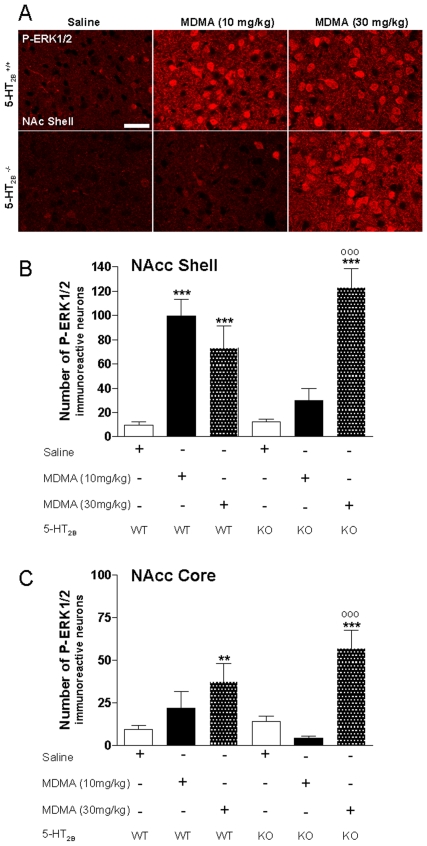
Effect of 5-HT2B receptor on MDMA-induced ERK activation.24 hours after CPP training (Figure 3), the same WT and 5-HT2B
−/− mice were re-exposed to saline, MDMA 10 mg/kg or MDMA 30 mg/kg before being processed for immunohistochemistry. A) Single confocal sections showing p-ERK1/2 immunoreactivity in the NAcc Shell of WT and 5-HT2B
−/−mice 10 min after re-exposure. Scale bar: 40 µm. B, C) Quantification of p-ERK1/2 immunoreactive neurons in the NAcc Shell (B) and NAcc Core (C) of WT and 5-HT2B
−/− mice 10 min after re-exposure. Note the strength of ERK activation induced by re-exposure to both MDMA doses in WT animals. This activation was absent in 5-HT2B
−/− mice at 10 mg/kg MDMA, although it fully recovered at 30 mg/kg MDMA. Data (means±SEM; n = 4−10 mice per group) were analyzed using two-way ANOVA with genotype and treatment as main factors, revealing a significant interaction in NAcc Shell F(2, 33) = 21.27, p<0,001 and in NAcc Core, F(2, 33) = 4.77, p<0.05. A main effect of treatment was observed in NAcc Shell F(2, 33) = 45.29, p<0,001 and in NAcc Core, F(2, 33) = 21.85, p<0,001, but no effect of genotype neither in NAcc Shell F(1, 33) = 0.53, ns nor in NAcc Core, F(1, 33) = 0.21, ns. Bonferroni tests were used for post-hoc comparisons. The null hypothesis was rejected at the p<0.05 level; ** p<0.01, *** p<0.001 compared to saline-treated mice; °°° p<0.001, compared to MDMA 10 mg/kg treated mice.